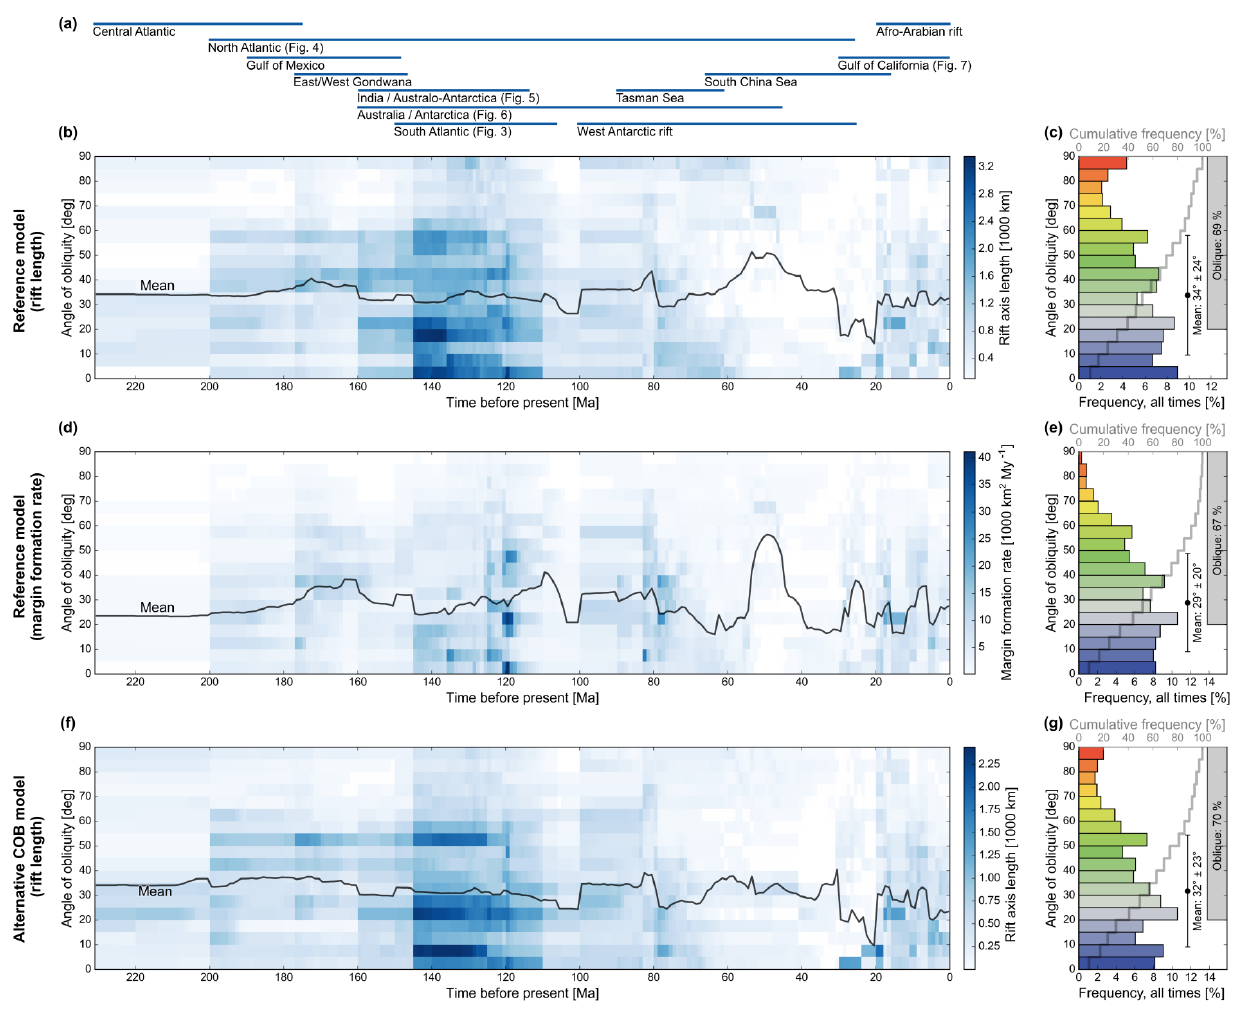
Figure 8. Global analysis of rift obliquity. (a) Variations of major rift system activity. Note that many rifts of the Atlantic and Indian Ocean were simultaneously active between 160 and 110Ma. (b, c) Rift obliquity in terms of rift length for the reference model employing late- breakup COBs (see Sect. 2.2 and Figs. 1 and 2 for more details). (d, e) The reference model analysed in terms of margin formation rate (i.e. rift segment length multiplied with segment-orthogonal velocity component). (f, g) An alternative model employing early-breakup COBs. All three models result in global mean rift obliquities of ∼ 30 ◦ and oblique rifting for more than ∼ 70% illustrating the robustness of our